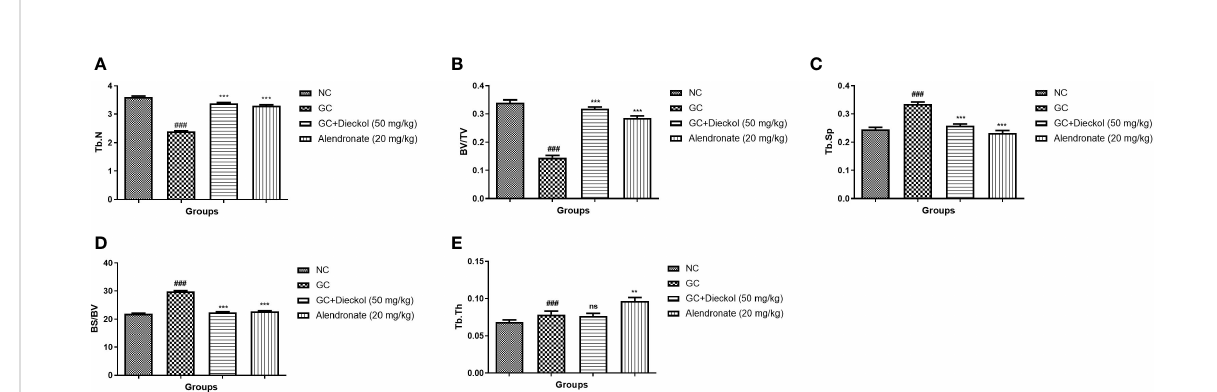
FIGURE 2 Dieckol showed an anti-glucocorticoid – induced osteoporosis effect on bone parameters in rats. (A) Tb.N, (B) BV/TV, (C) Tb.Sp, (D) BS/BV, and (E) Tb.Th. Results are shown as means ± SEM (n = 12). ***P < 0.001 when contrasted with the disease group and the normal